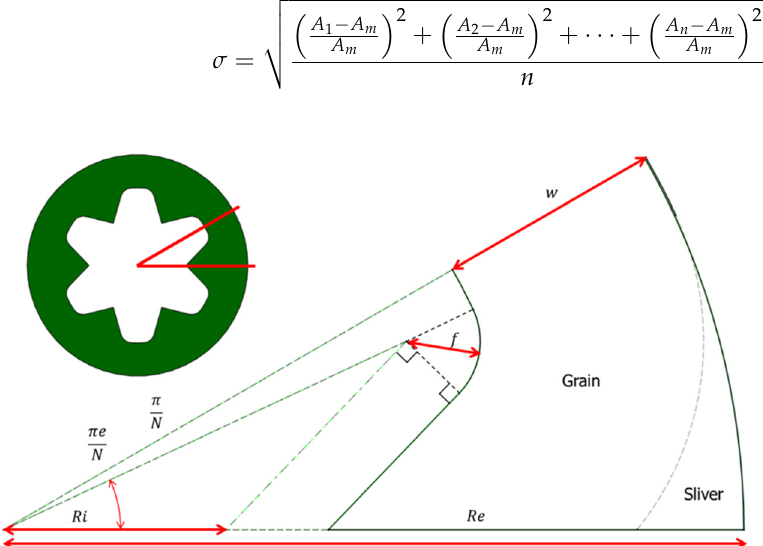
Figure 2. Star grain configuration. Table 1. Star grain configuration